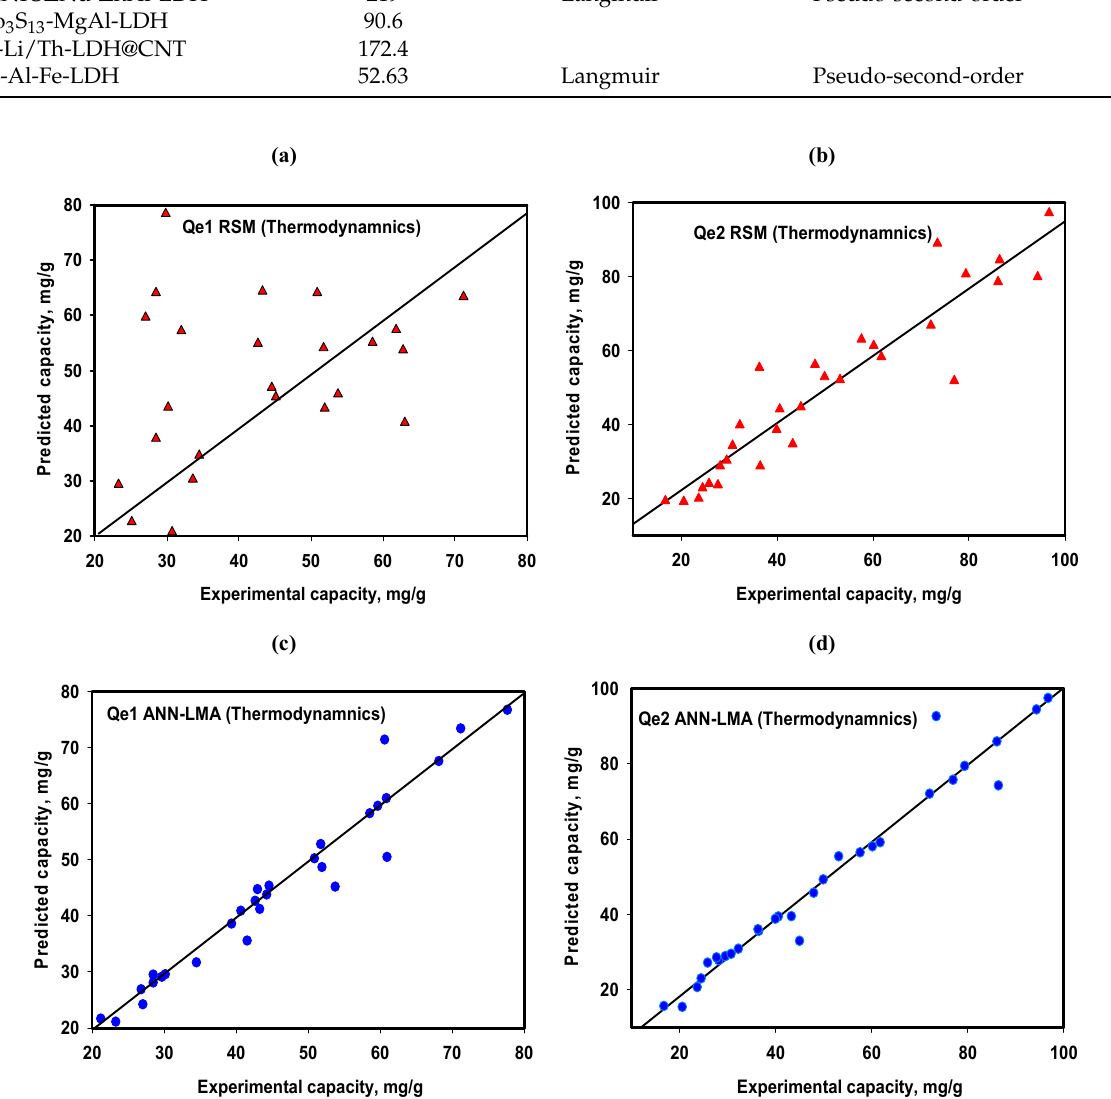
Figure 11. Experimental vs. predicted plots RSM FCC-CD ( a , b ) and ANN-LMA models ( c , d ) for thermodynamics of Cr(VI) uptake by CoAl-LDH and bentonite-CoAl-LDH. The ANN-LMA and RSM models predicted Langmuir constants K L in L/mg (Table 9) is converted to L/mmol as K d , from which the thermodynamics parameters (Gibbs free Δ G °, energy enthalpy Δ H and entropy change Δ S ) were further estimated and compared with those obtained from the experiment data (i.e., actual values). At temperatures of 25, 35 and 45 °C, the values Δ G ° were calculated using Equation (7) from which ∆ S and ∆ H , as listed in Table 9, were estimated using slope and intercepts from the linear plot between Ln ( K d ) and 1/T in Equation (8).